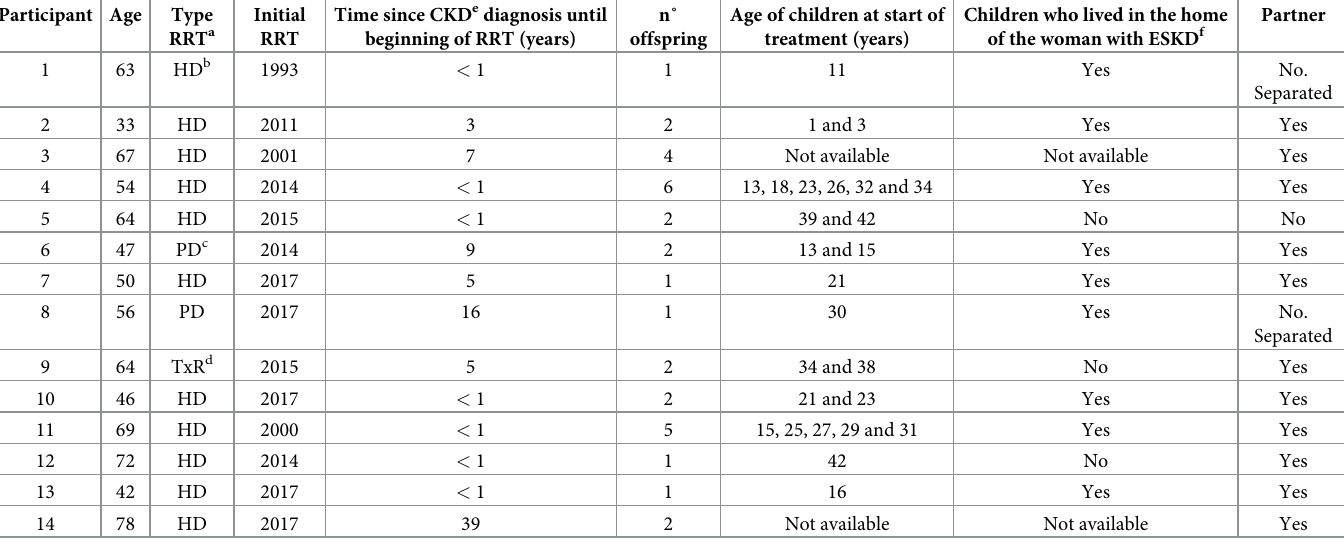
Table 2. Data on renal replacement therapy, and age of the children at the start of